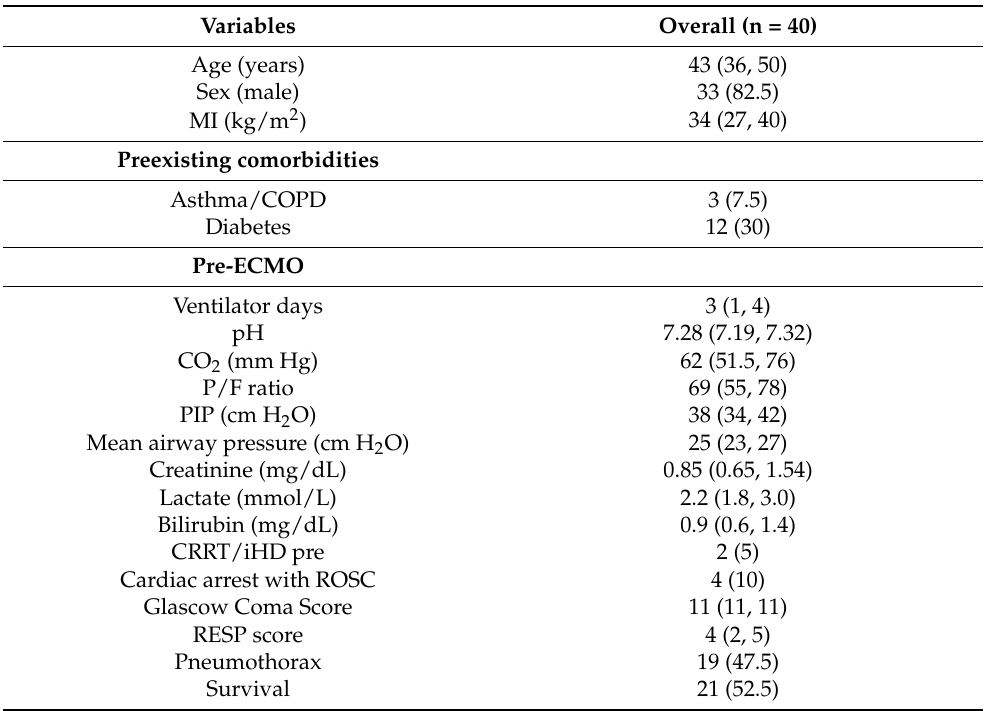
Table 2. Patient characteristics and